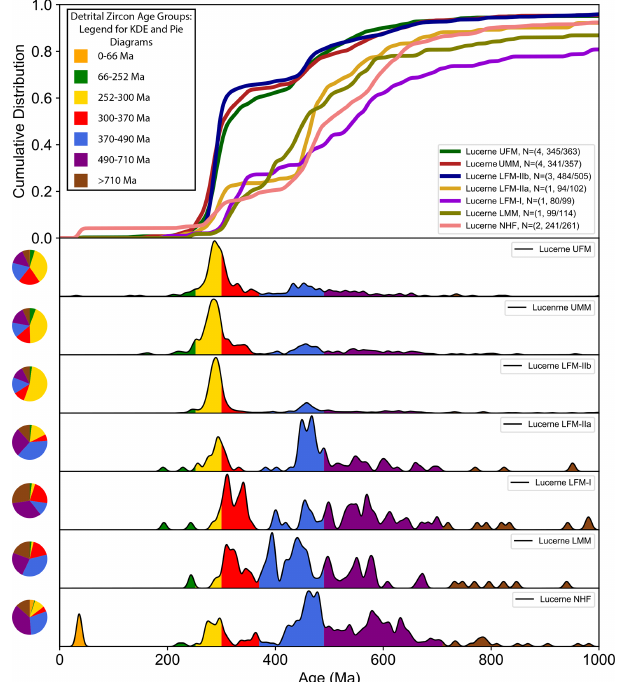
Figure 4. Detrital zircon U–Pb age data from the Lucerne Section (locations of samples depicted in Fig. 3a) plotted as kernel density estimations (KDEs; Bandwidth set to 10), a cumulative distribution plot (CDP), and as pie diagrams. Colored bars in the KDE and col- ored wedges in the pie diagrams show the relative abundance of age groups discussed in Sect. 5. Samples associated with each unit are referenced in Table 1. Plot only shows ages from 0 to 1000Ma; however, a small number of older ages were analyzed, and those data can be found in Table S1. N : number of samples, number of ages depicted/total number of ages).